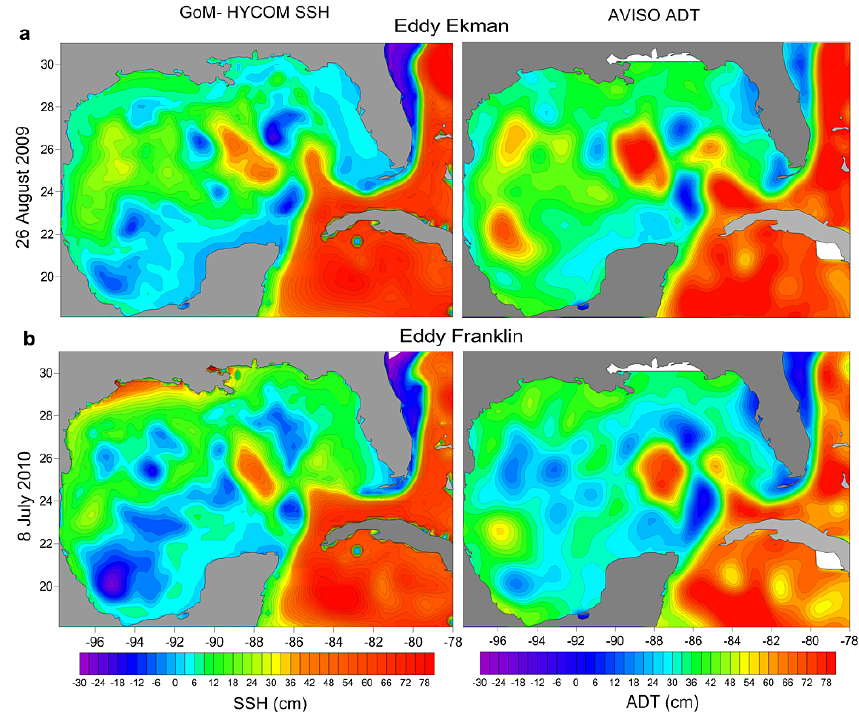
Figure 3. (left) Daily GoM-HYCOM Sea Surface Height (SSH, cm) for two characteristic LCE separation dates of (a) the Eddy Ekman event (26 August 2009) and (b) the Eddy Franklin event (8 July 2010), as well as (right) the respective weekly AVISO ADT (cm). The large cyclonic LCFEs between the anticyclonic LCEs and the main LC body are of N Group type (migrating southward from the northern GoM) and of CB Group type (migrating northward from the vicinity of the Campeche Bank).